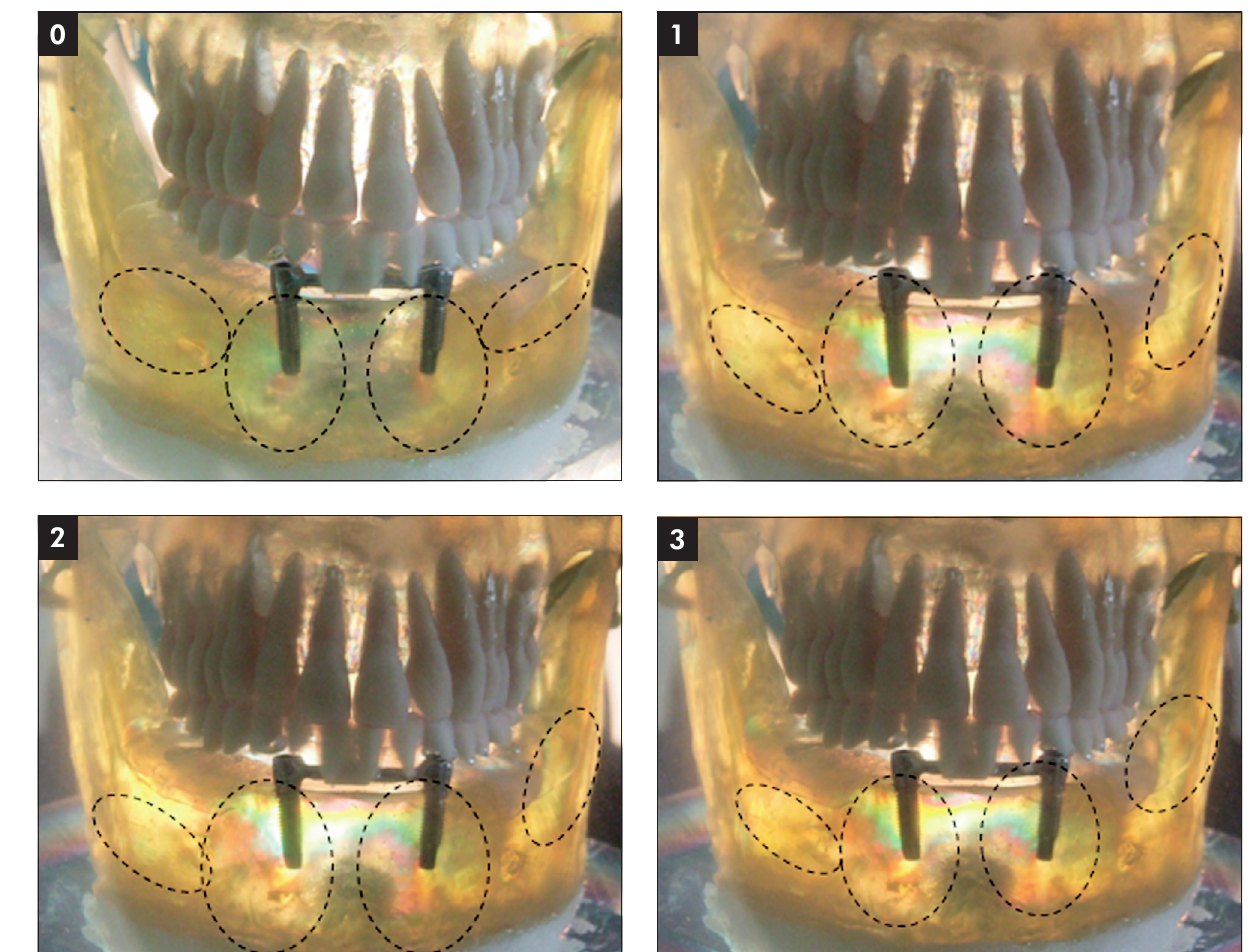
Figure 3 - PAAI: Bar-clip overdenture on two angled implants, followed by load